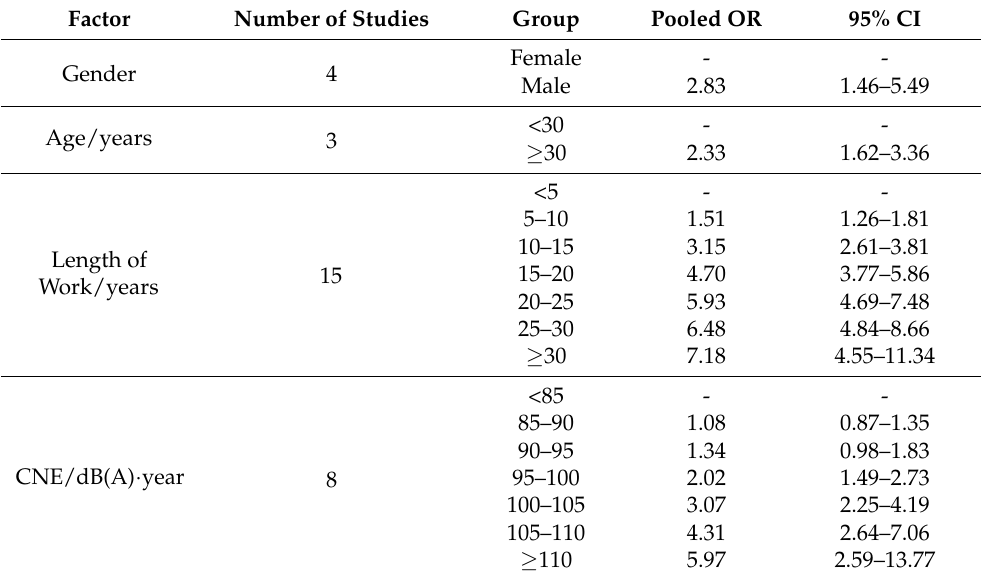
Figure 5. Funnel plot analysis of noise exposure and risk of HFNIHL.